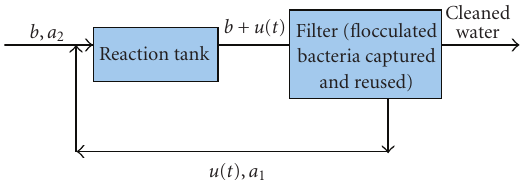
Figure 2: Simplified diagram of an activated sludge